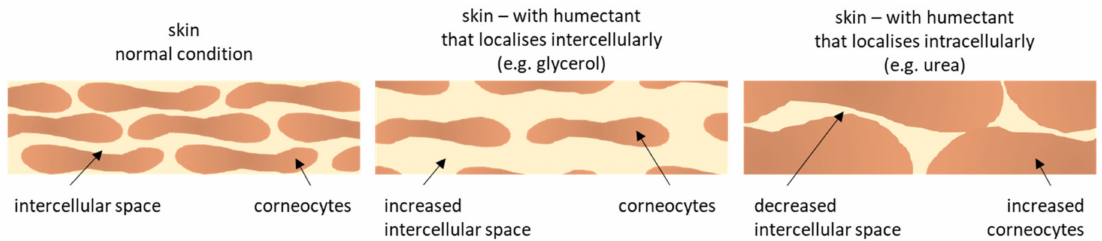
Figure 6. Principle of penetration enhancing properties of di ff erent